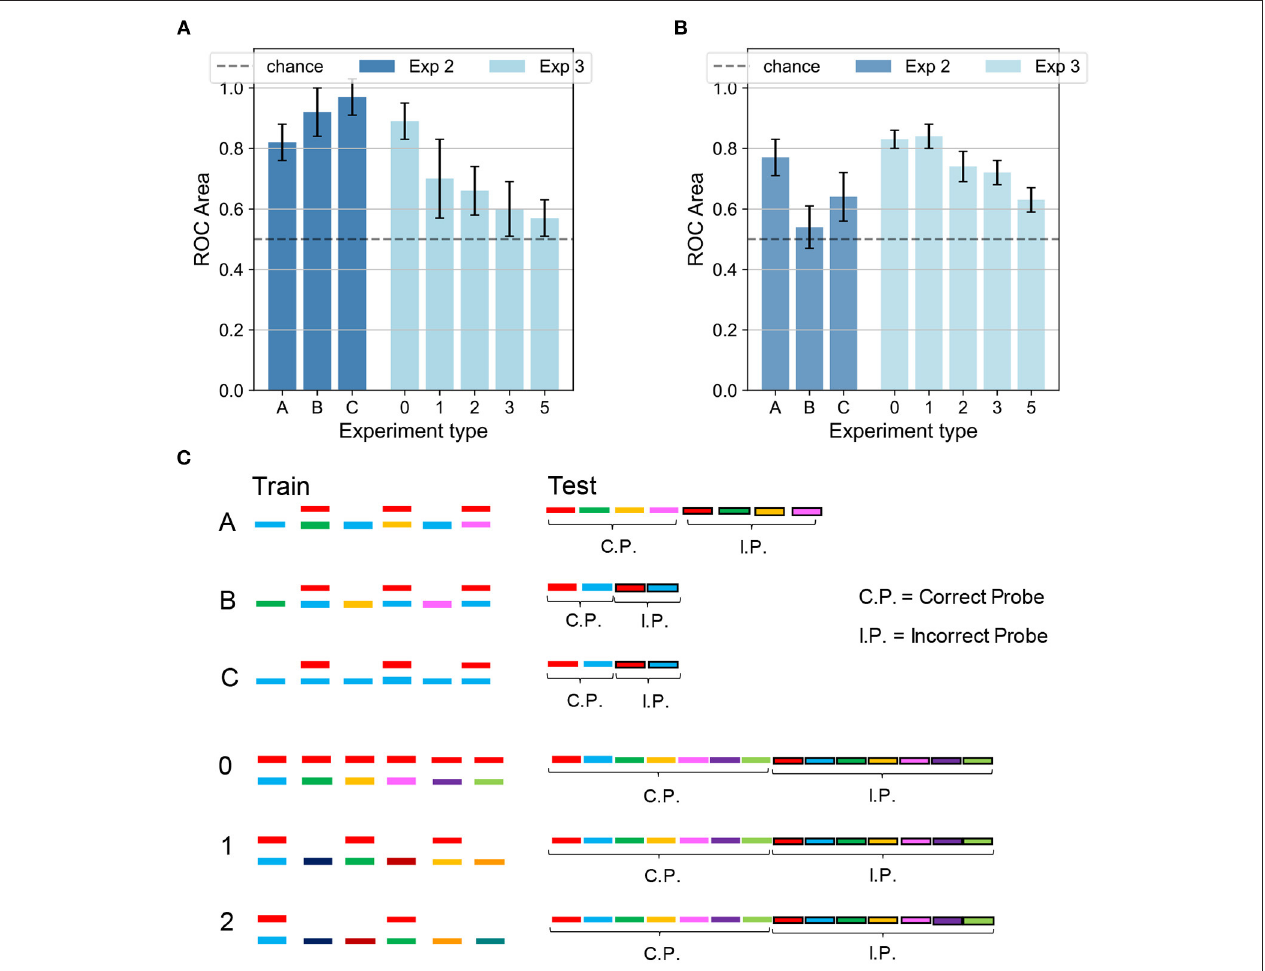
FIGURE 6 | Experiments 2 and 3—results and comparison with human performance. (A) Results for Experiments 2 (dark blue) and 3 (light blue) on the dendritic network model. In Experiment 2 the performance is above chance for the three conditions. In Experiment 3 the accuracy decreases as the number of isolated sounds alternating with the mixtures increases. (B) Results for Experiments 2 (dark blue) and 3 (light blue) on the human experiment. In Experiment 2 the performance is above chance in the conditions A and C, while it is random for condition B. In Experiment 3 the accuracy decreases as the target presentation is more delayed. Figure reproduced based on data acquired by McDermott et al. (2011). (C) Schematics for Experiments 2 and 3. The training is the same for both the dendritic network model and the human experiment. The schematics is omitted for delays 3 and 5. The testing refers to the dendritic network model, while the testing for the human experiment (same as in Figure 5B ) is omitted. In (A,B) , the height of the bars and the error bars show respectively mean and standard deviation of the AUC over 10 independent